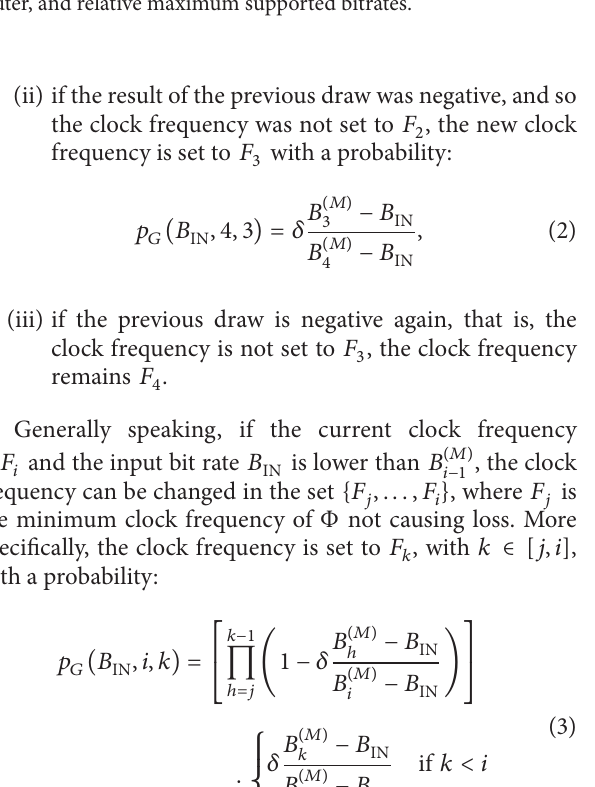
Figure 2: Set of clock frequency implemented by the router, and relative maximum supported